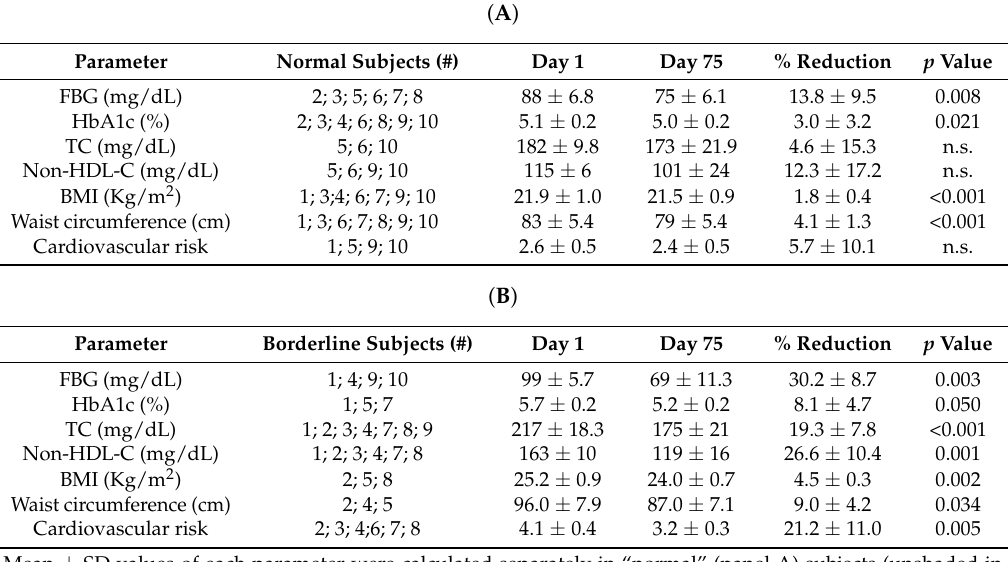
Table 5. Metabolic parameters of subjects with normal or borderline values at day 1, treated for 75 days with the ABA-rich food